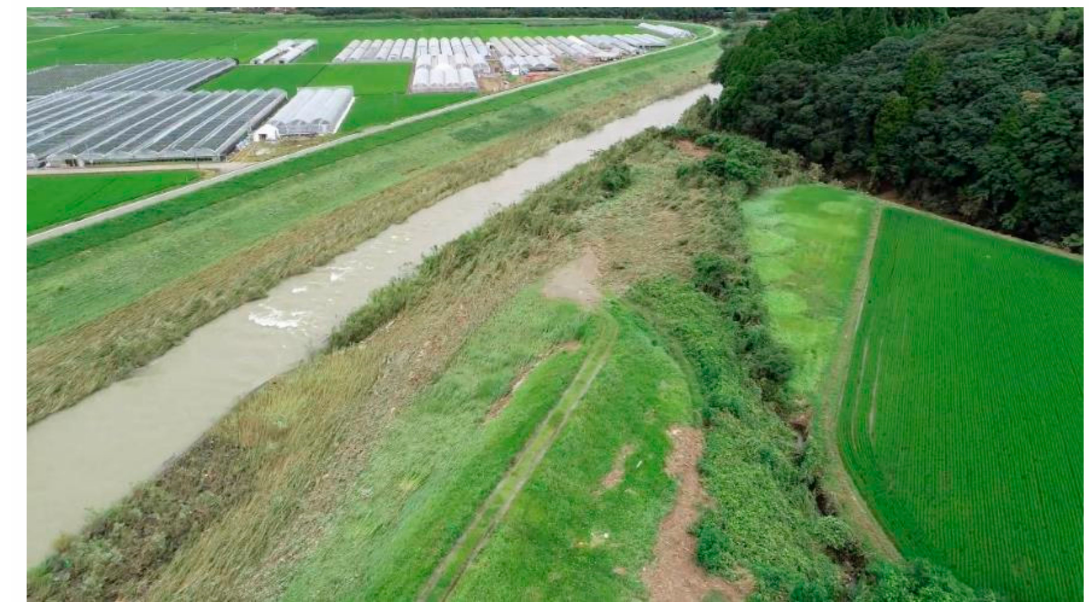
Figure 6. Damage of the Okawano open levee after the